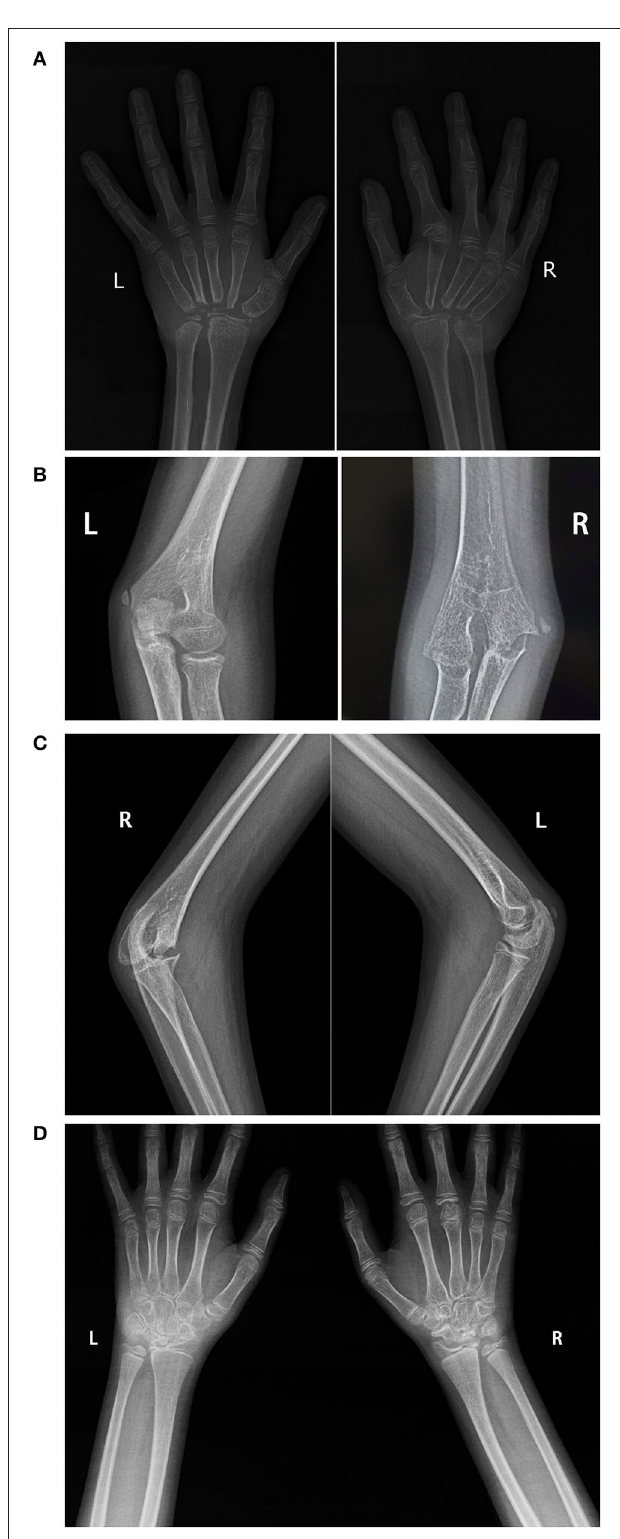
FIGURE 2 | Radiological findings. X-ray of the hands of patient 1 (A) , taken at 12 years old, showing severe erosion of the carpal bones and the proximal